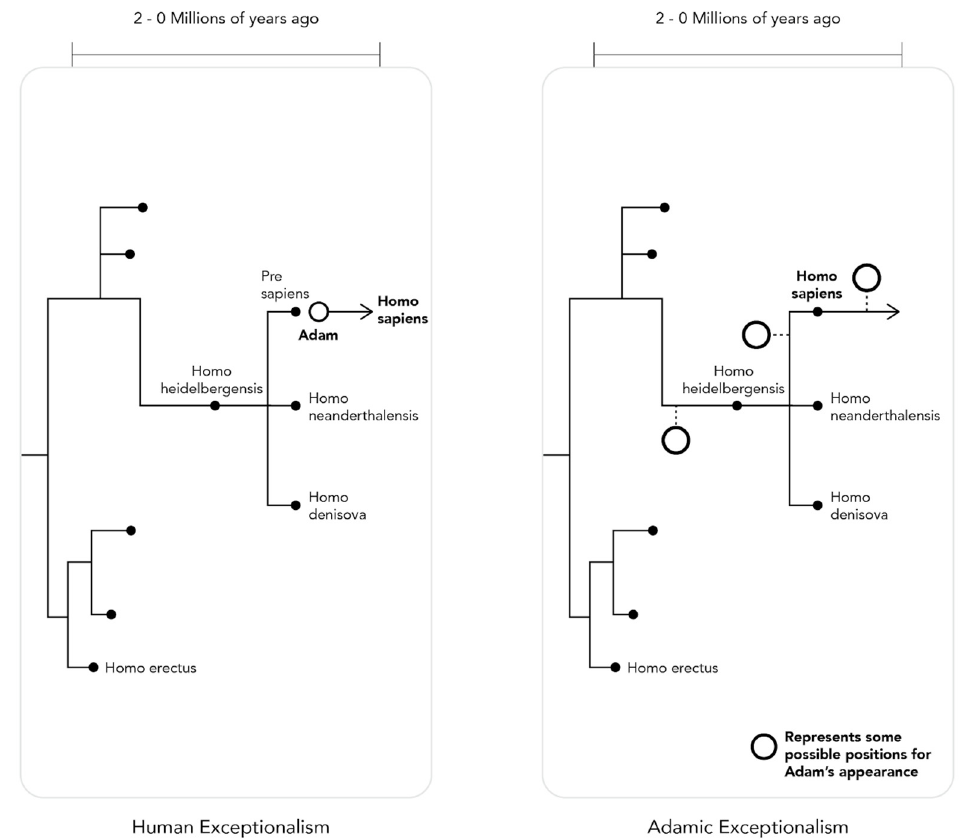
Figure 1. The difference between human ( left ) and Adamic ( right ) exceptionalism. 26 .